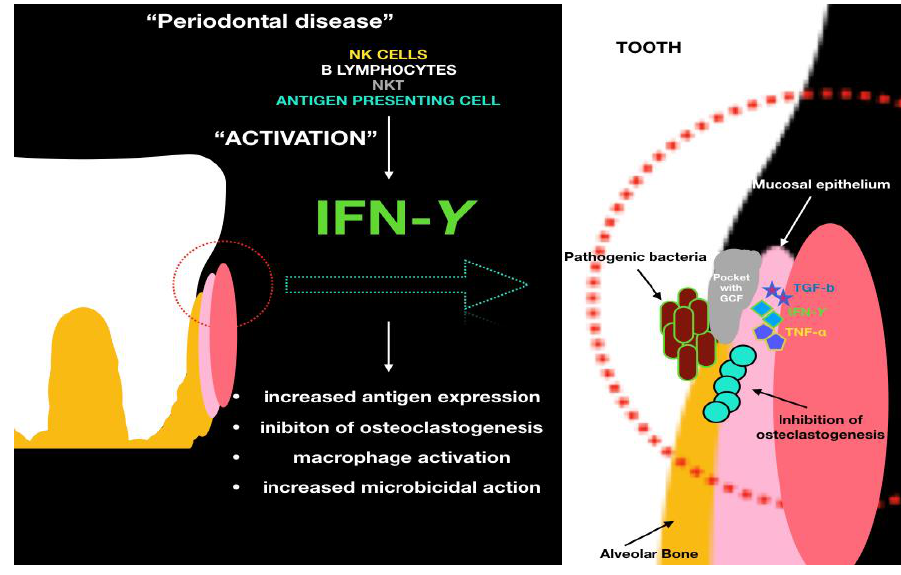
Figure 2. The role of IFN-γ and the cellular mechanisms involved in the wound healing